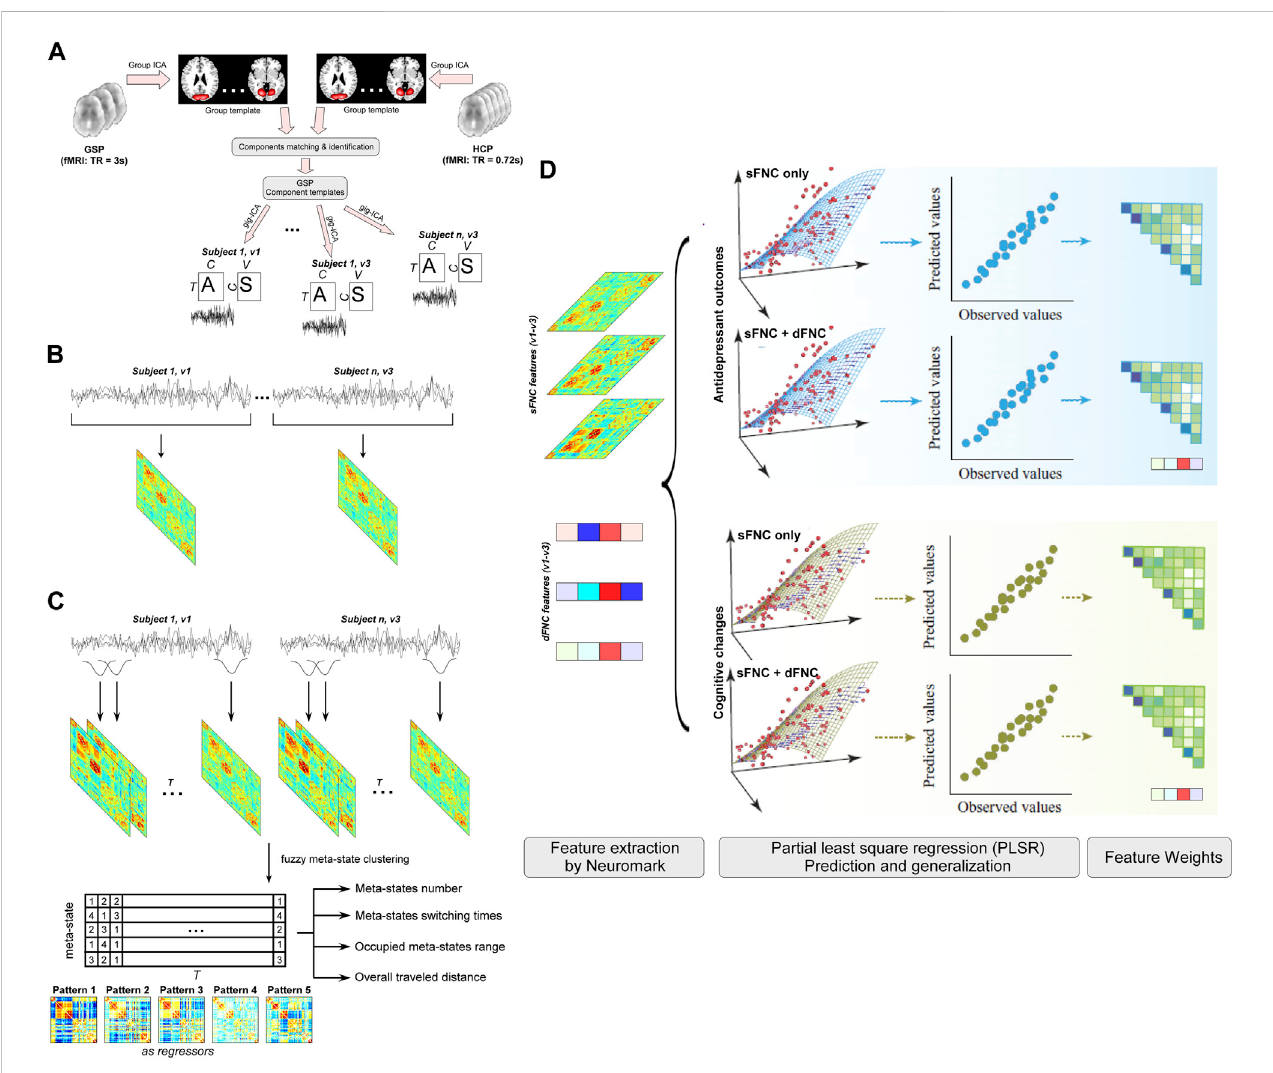
FIGURE 1 Flowchartofthepredictionanalyses.ToexaminewhetherECT-inducedantidepressantoutcomesandcognitivechangeshaveneuralrepresentationson static and dynamic functional connectivity, we develop separate predictive models for HDRS and HVLT based on the sFNC features and global dynamism features and examine their weight maps at connection and functional domain levels. (A) Templates construction and individual network estimation. (B) Static functional network connectivity (sFNC) features. (C) Dynamic functional network connectivity (dFNC) features. (D) Prediction of ECT